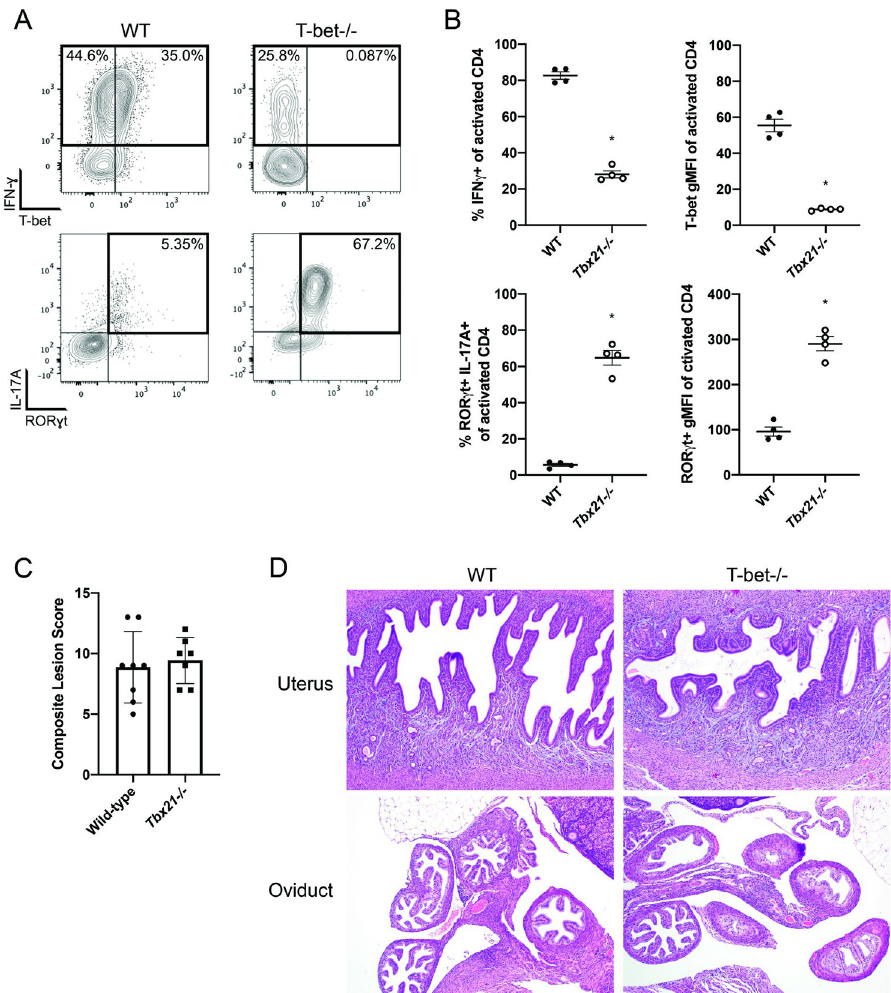
Fig 4. T-bet deficient mice make T-bet independent IFN- γ and shift towards Th17 responses. Mice received 2.5mg Depo-Provera 7 days before infection with 1x10 5 IFU Chlamydia muridarum i.vag. (A) 17 days post infection lymphocytes were isolated and stimulated with PMA/ionomycin and Brefeldin A and stained for flow cytometry. n = 4 for both groups. Plots are gated on CD44 hi CD62L lo CD4 T cells. Results are representative of two experiments. (B) Summary plots from (A). (C) Summary of composite lesion scores for wild-type and Tbx21-/- FRT tissue sections on day 61 post infection. Graph comprises two experiments, total n = 8 for both groups though one mouse from Tbx21-/- group was excluded due to suspected imperforate vagina and non-productive infection. p = 0.549, Mann-Whitney test. (D) Example histology slides from part